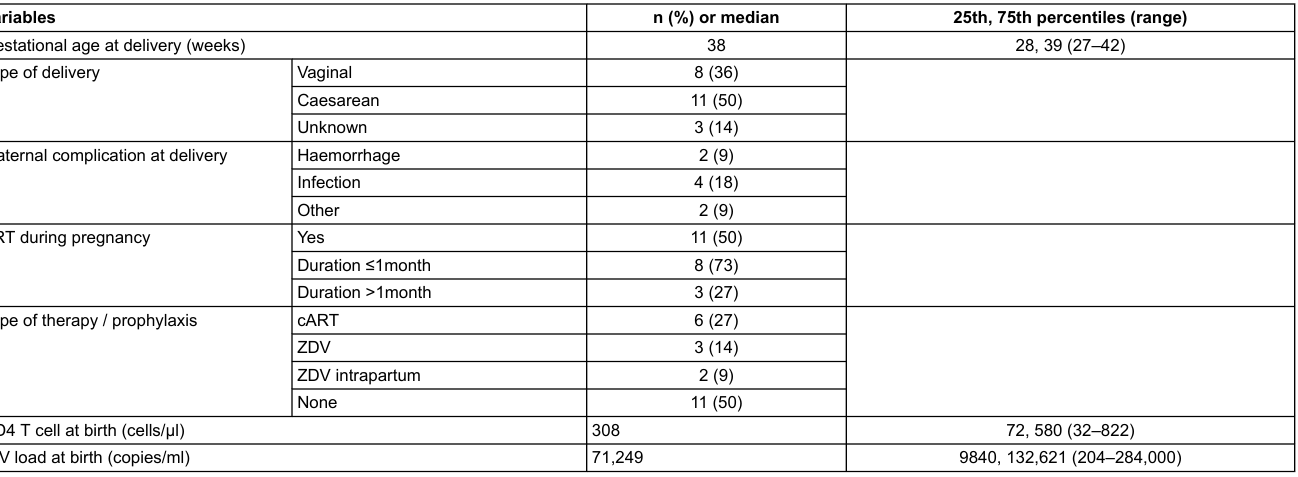
Table 1: Clinical characteristics of mothers in MTCT